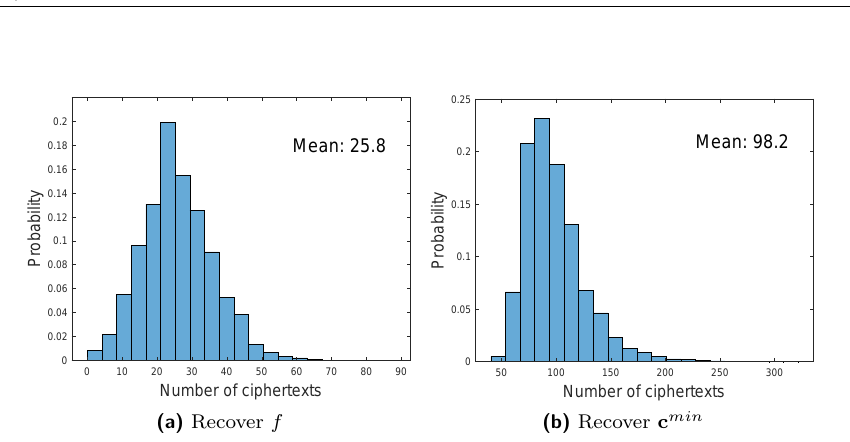
Figure 6: Distribution of N c for PRESENT, 10000